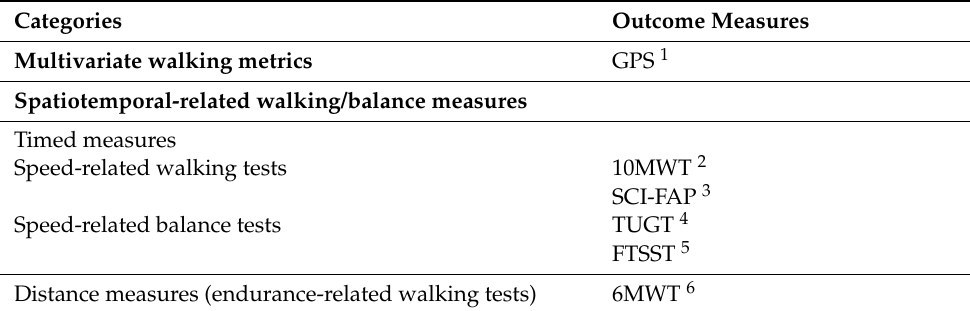
Table 2. Categories of walking ability outcome measures in